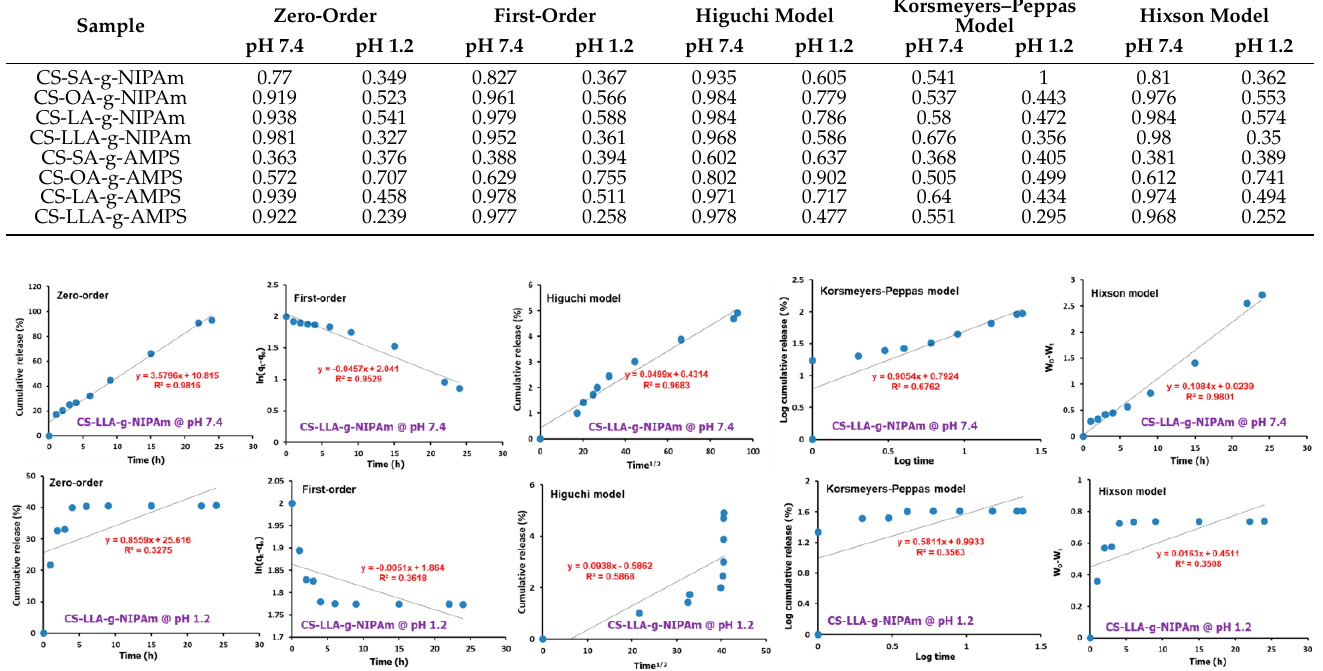
Figure 7. Kinetic study parameters of CS ‐ LLA ‐ g ‐ NIPAm at two different pHs of 1.2 and 7.4.